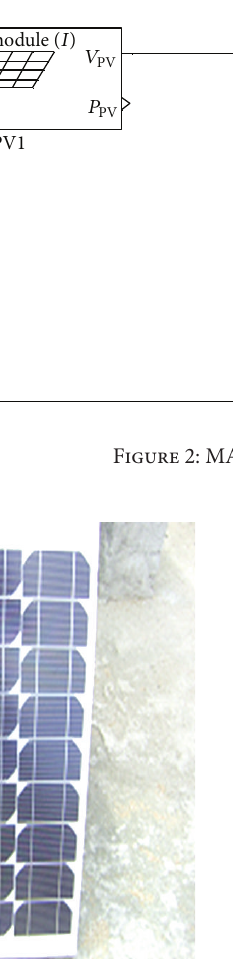
Figure 3: L1235-37W solar module under test.